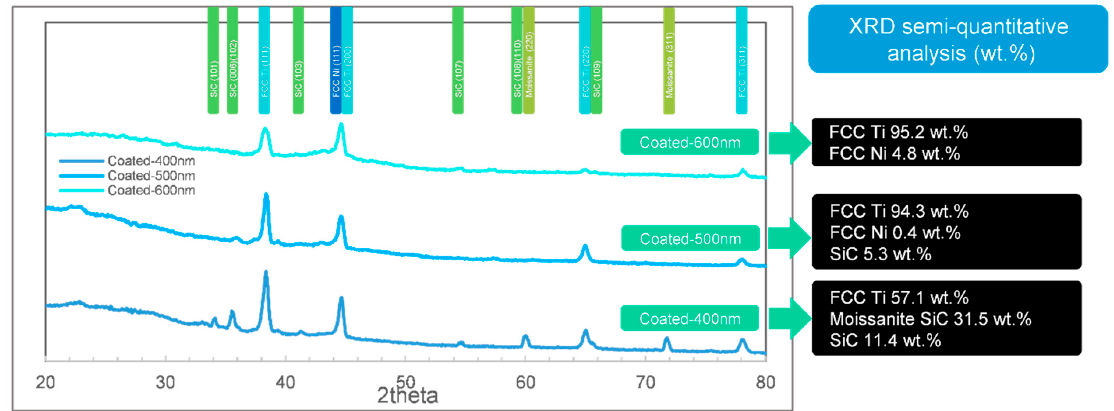
Figure 7. The and X-ray diffraction (XRD) phase identifications (semi-quantitative analysis) by full width at half the maximum method (FWHM) of the as-coated samples ranging from 400 to 600 nm.